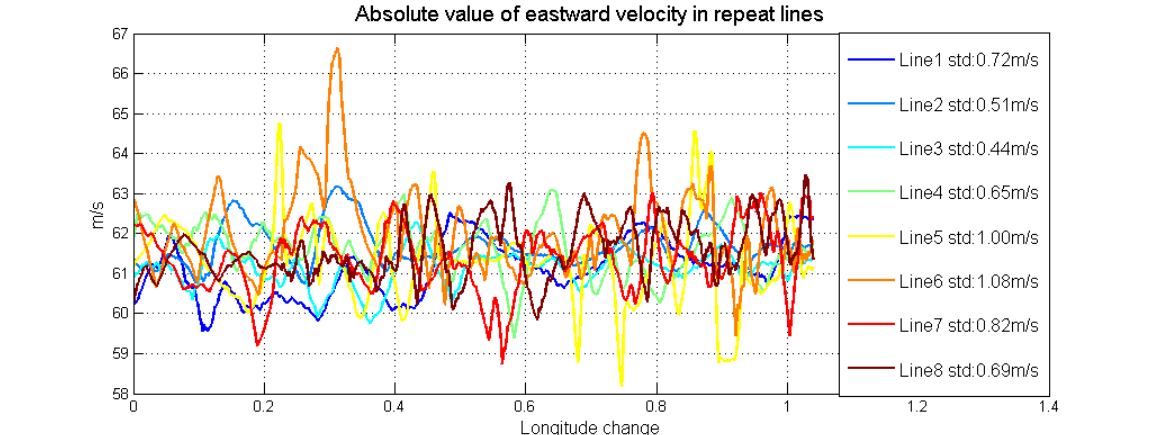
Figure 13. Absolute value of eastward velocity in repeat